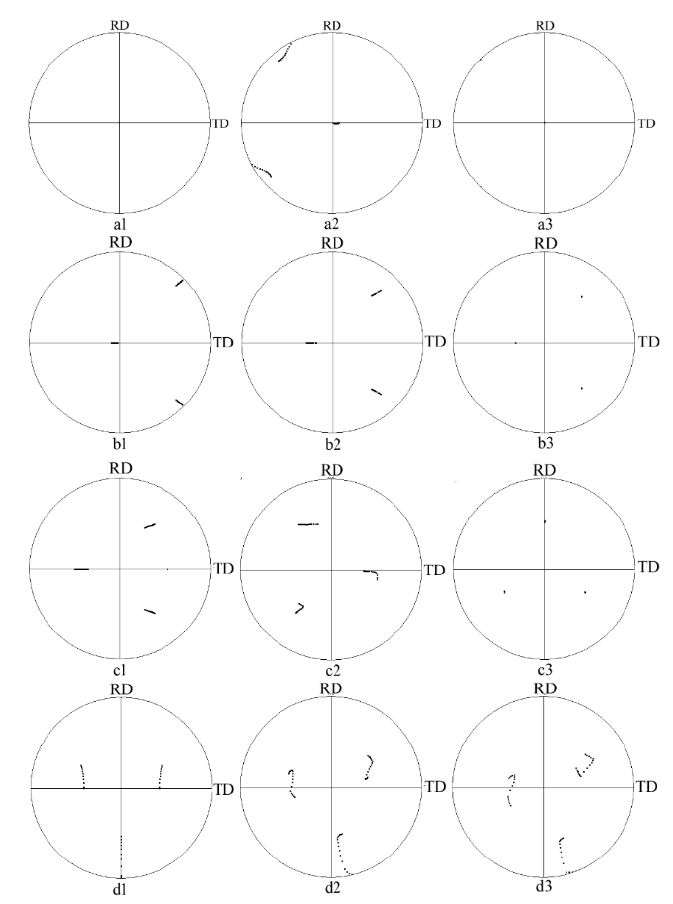
Figure 7. Calculated orientation change of typical texture components of BCC steel during rolling deformation to ε 33 = − 1.1, {200} pole figures. ( a1 ) (45° 0° 45°); ( a2 ) (20° 0° 45°); ( a3 ) (0° 0° 45°); ( b1 ) (0° 10° 45°); ( b2 ) (0° 20° 45°); ( b3 ) (0° 35° 45°); ( c1 ) (0° 55° 45°); ( c2 ) (15° 55° 45°); ( c3 ) (90° 55° 45°); ( d1 ) (90° 90° 45°); ( d2 ) (75° 90° 45°); ( d3 ) (60° 90° 45°).